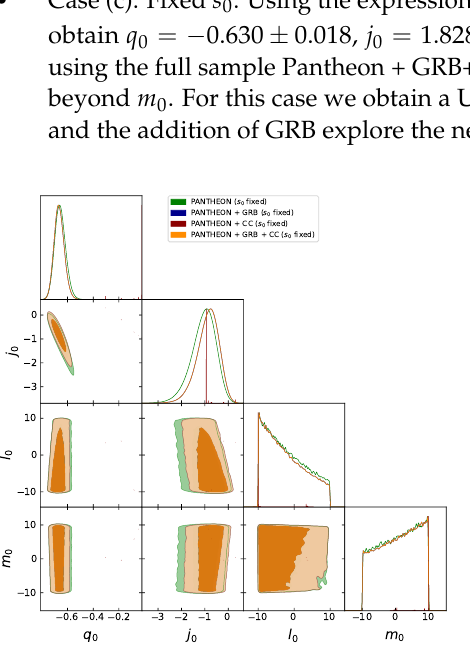
Figure 3. Case (c) using Pantheon compilation (green C.L.), Pantheon+GRB (blue C.L.), Pantheon+CC (red C.L.) and Pantheon+GRB+CC (orange C.L.).